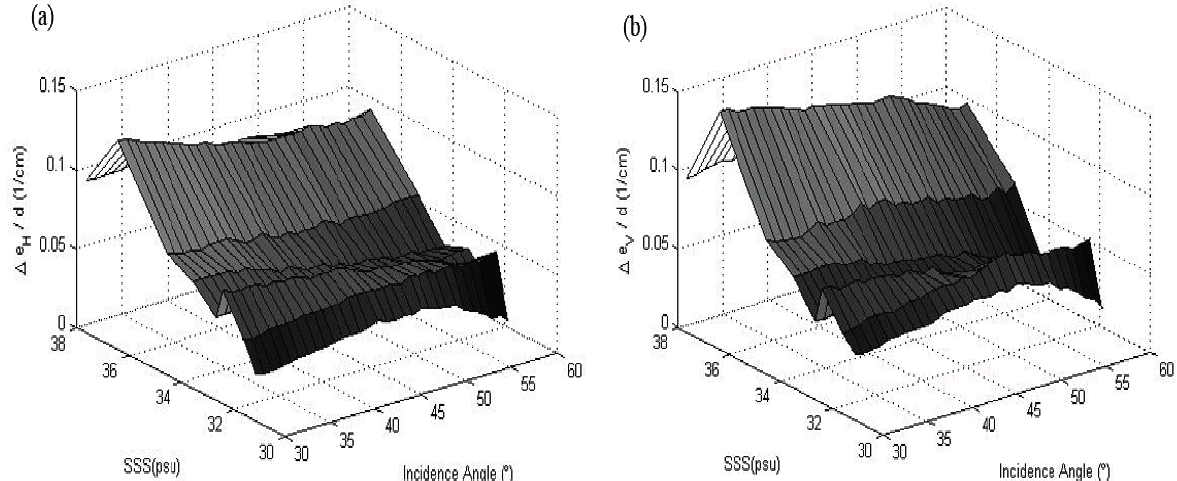
Figure 5. Average emissivity increments and incidence angle: ( a ) at horizontal polarization; ( b ) at vertical